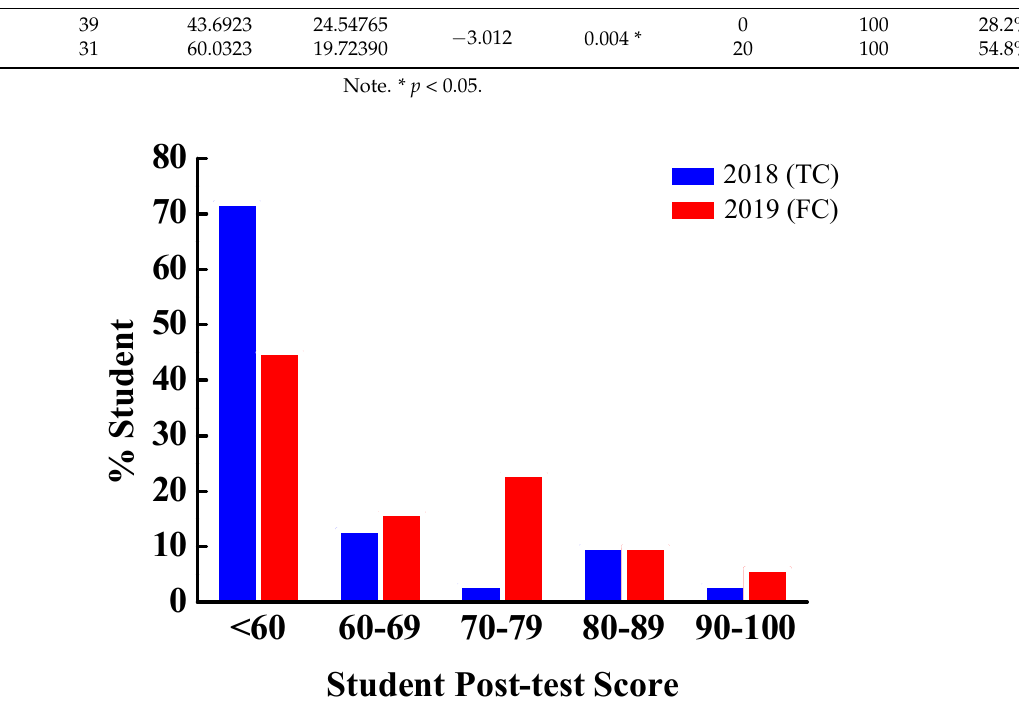
Figure 7. Student post-test score distribution under the TC and FC model.